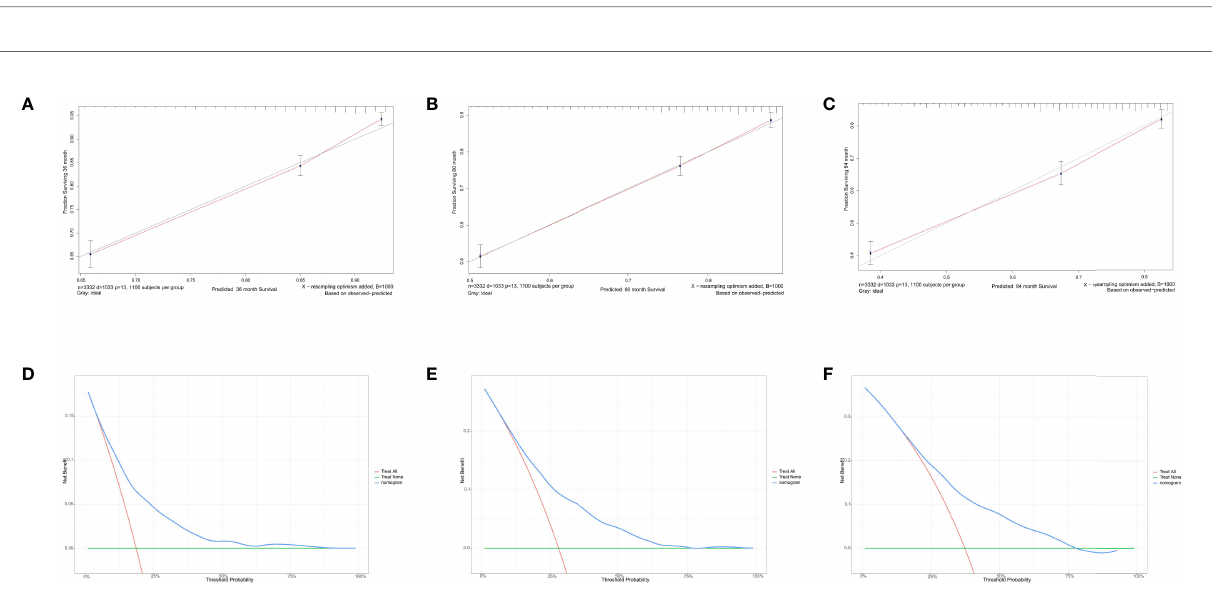
FIGURE 7 | Calibration curves and decision curve analysis for evaluating the accuracy of the nomogram in predicting the overall survival. The solid red line represented the performance of the nomogram, of which the closer fi t to the gray line represents the better prediction of the nomogram we constructed. (A) 3-year OS in elderly primary operable TNBC patients, (B) 5-year OS in elderly primary operable TNBC patients; (C) 7-year OS in elderly primary operable TNBC patients; (D) DCA for 3-year OS in elderly primary operable TNBC patients in the training cohort; (E) DCA for 5-year OS in elderly primary operable TNBC patients in the training cohort; (F) DCA for 7-year OS in elderly primary operable TNBC patients in the training cohort. OS, overall survival; DCA, decision curve analysis; TNBC, triple-negative breast cancer.